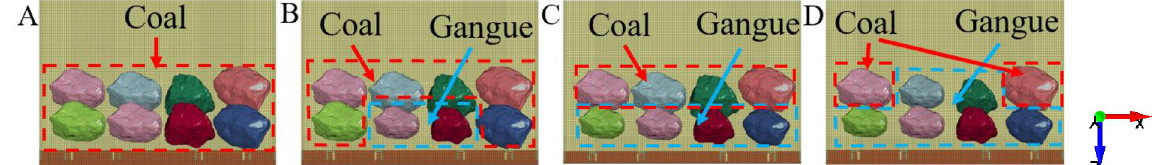
Fig 7. Four coal gangue particles slipping tests with different gangue content. (A) The gangue content is 0%. (B) The gangue content is 25%. (C) The gangue content is 50%. (D) The gangue content is 75%.